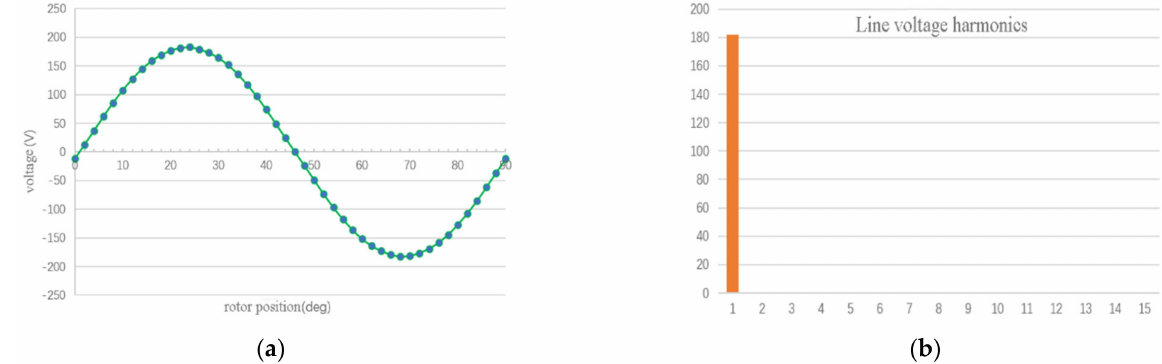
Figure 3. ( a ) Line voltage waveform; ( b ) Harmonic component of line voltage.